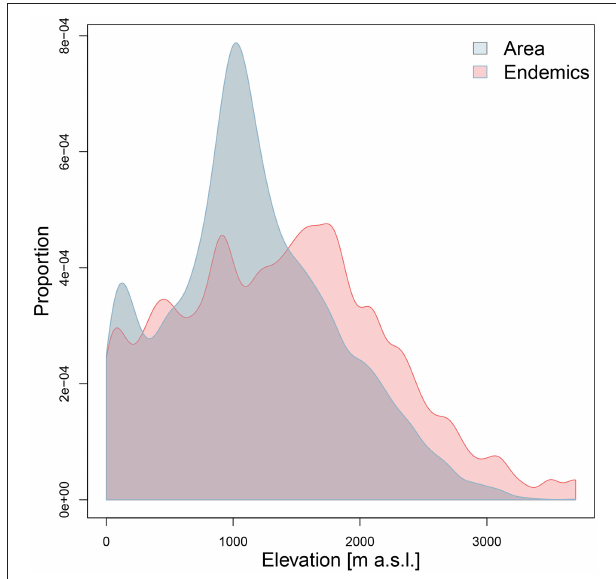
FIGURE 6 | Proportion of total surface area and endemic richness along the elevational gradient.